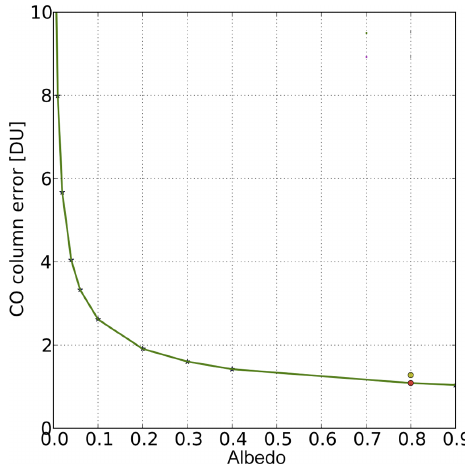
Figure 3. Dependence of the CO column uncertainty (Dobson unit) on the surface albedo. Simulation settings are solar zenith angle 53 ◦ , viewing zenith angle 26 ◦ relative azimuth angle 0 ◦ , and cloud– surface pressure